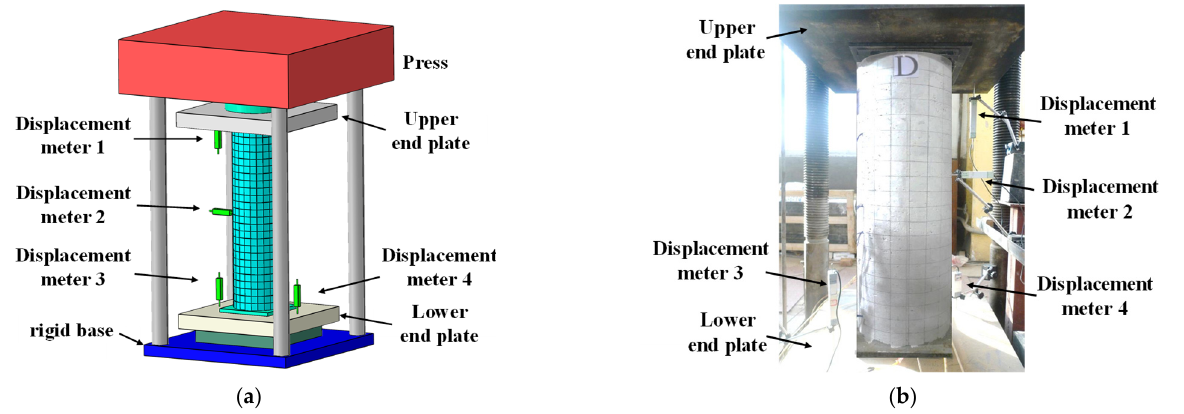
Figure 3. Loading device. ( a ) Simulated loading device ( b ) Test site conditions. Table 1. Parameters of the specimens .